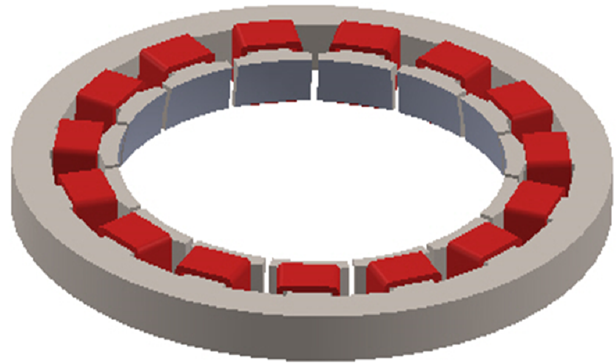
Figure 9. Outer stator model.